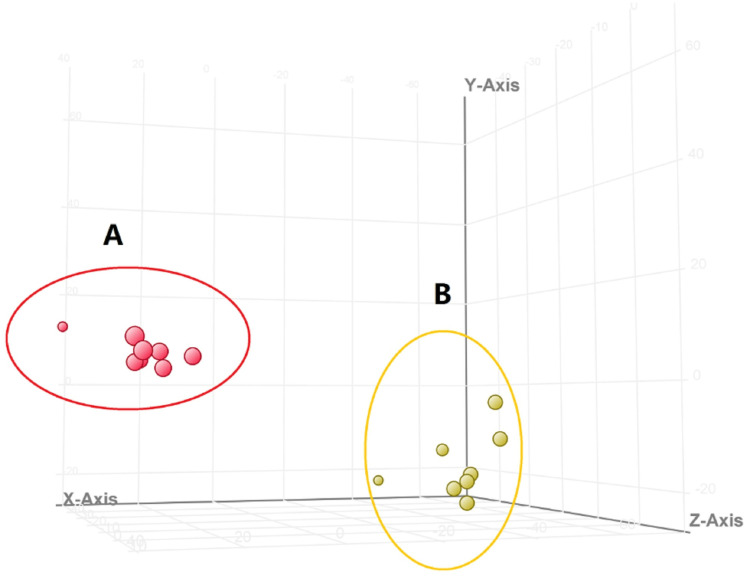
The results of PCA in the positive ion mode.(A, tumor group, B, dose group).